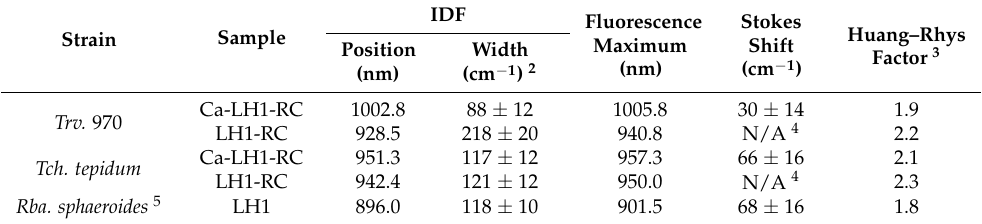
Table 2. Exciton–phonon coupling and disorder parameters for the core complexes studied at 4.5 K 1